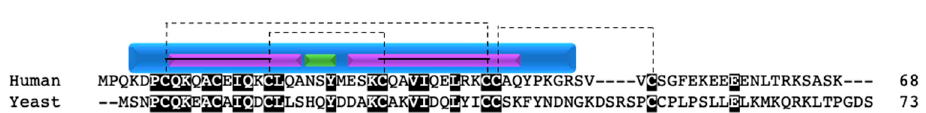
Figure 13. CMC4. Alignment of human and yeast CMC4 protein sequences. Black boxes indicate conserved residues. Human sequence annotation is as follows: Purple boxes indicate a helix. Green boxes indicate a turn. Blue box indicates the CHCH domain. Solid black lines indicate the twin CX 9 C motif. Dashed lines indicate the cysteine pairs that form structural disulfide